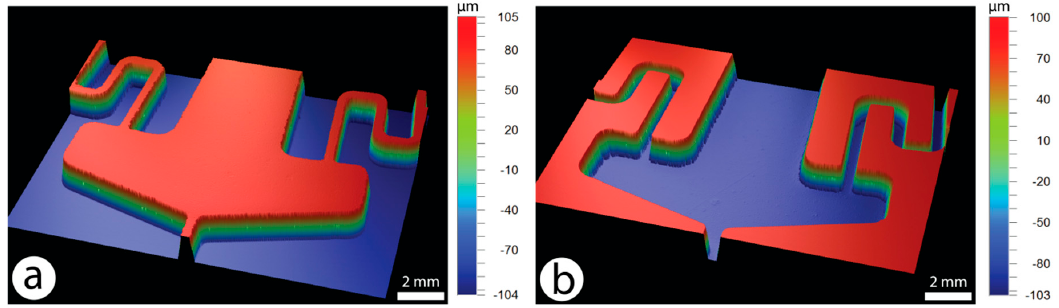
Figure 4. Profiles, acquired using a profilometer (Dektak 150), of ( a ) SU-8 master used for embossing and ( b ) profile of embossed PMMA mixing structure.